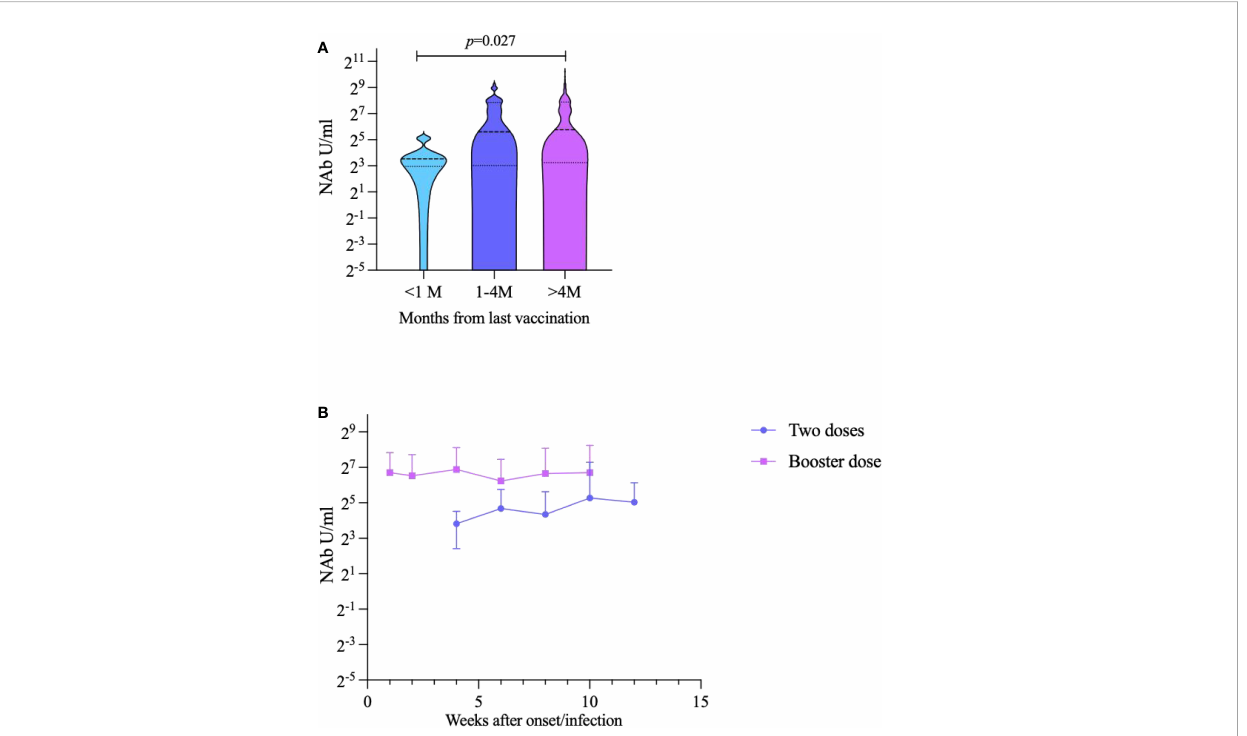
FIGURE 4 Impact of inactivates SARS-CoV-2 vaccination to NAbs against Omicron BA.2 variant in breakthrough cases. (A) Breakthrough case classi fi cation analysis according to the time since the last vaccination to sampling. (B) Trends in NAb over time for different vaccination doses.